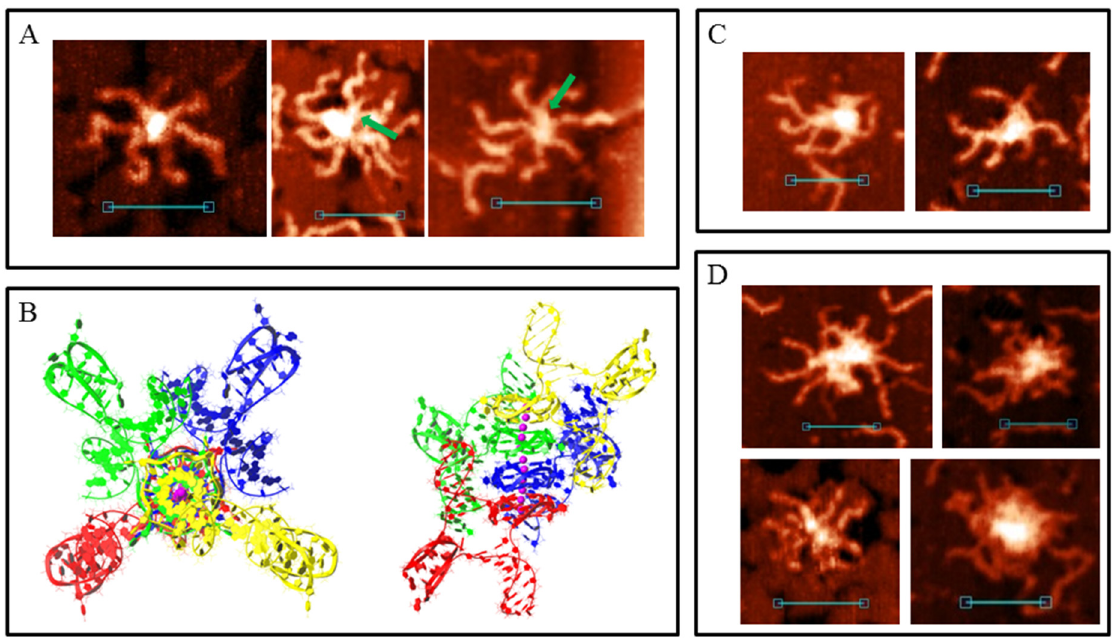
Figure 6. Multimeric synaptic complexes formed by 4m sample. ( A ) Examples of the complexes formed through stacking of four intramolecular G4s, revealed by AFM. Green arrows indicate folded top IM structures. Scale bars: 50 nm. ( B ) Molecular model of the structure, consistent with ( A ) (top and side views). ( C ) Tetramolecular synaptic complexes formed by 4m sample through a combination of G4-G4 stacking and the formation of two intermolecular IMs separated by thymidine residues. ( D ) Big complexes with indistinguishable structures. Scale bars: 50 nm.